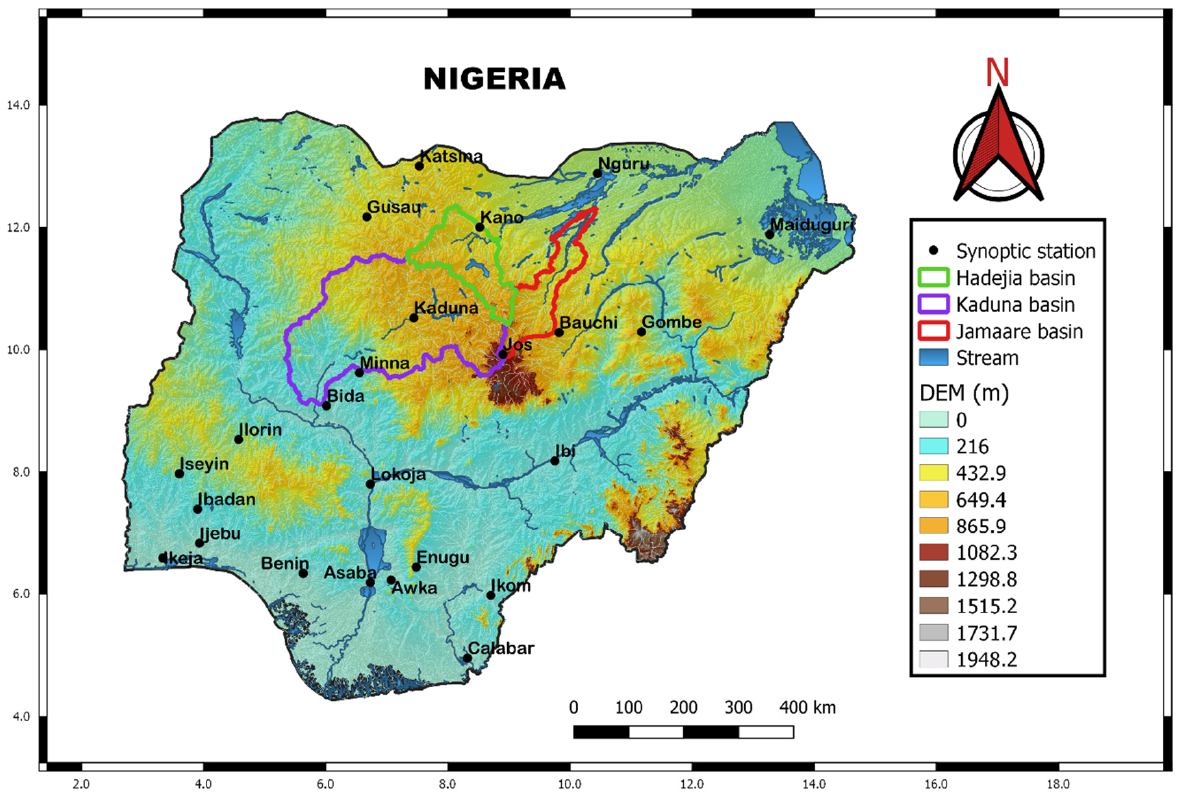
Figure 1. Map of Nigeria showing synoptic stations over three distinct climatic regions. The study basins are the Kaduna (64,848 km 2 ), Hadejia (16,820 km 2 ), and Jamaare (13,929 km 2 ) River Basin systems, which are located in the semi-arid north–central region of Nigeria (Figure 2). This region is characterized by sparse vegetation with scattered shrubs occasioned by frequent droughts and high rainfall variability [16,65]. The majority of the inhabitants dwelling in the Hadejia–Jamaare river basin are involved in cattle rearing,